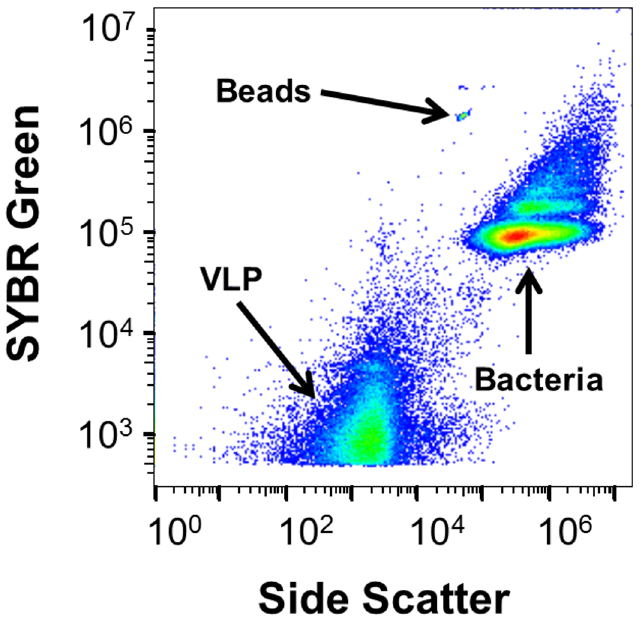
Fig 1. Bacterial and VLP identification using side-scatter and green fluorescence. Representative cytogram shows the VLP and bacterial populations in a patient ’ s untreated sinus wash.